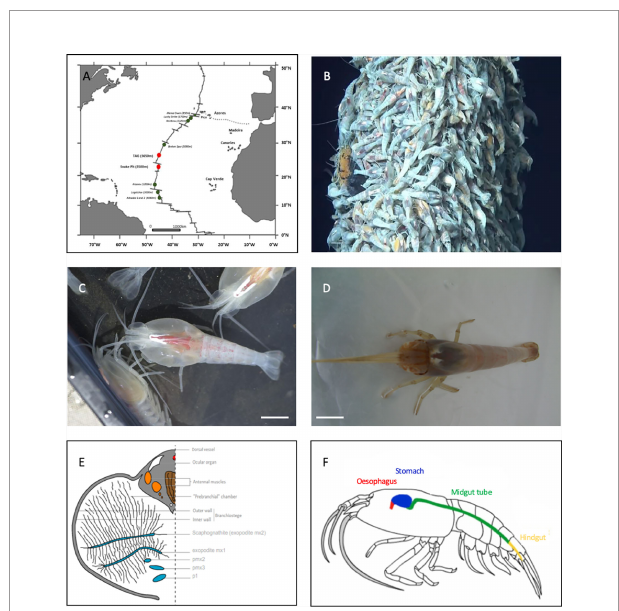
FIGURE 1 | Study models. (A) Two main study sites on the MAR: TAG and Snake Pit. (B) Rimicaris exoculata aggregations on a hydrothermal vent at the TAG site (Nautile-BICOSE2, 2018). (C) Adult Rimicaris exoculata . (D) Adult Rimicaris chacei . (E) Transversal section of half of the cephalothoracic cavity of R. exoculata (adapted from Segonzac et al., 1993). (F) Digestive system of Rimicaris spp. (adapted from Durand et al.,